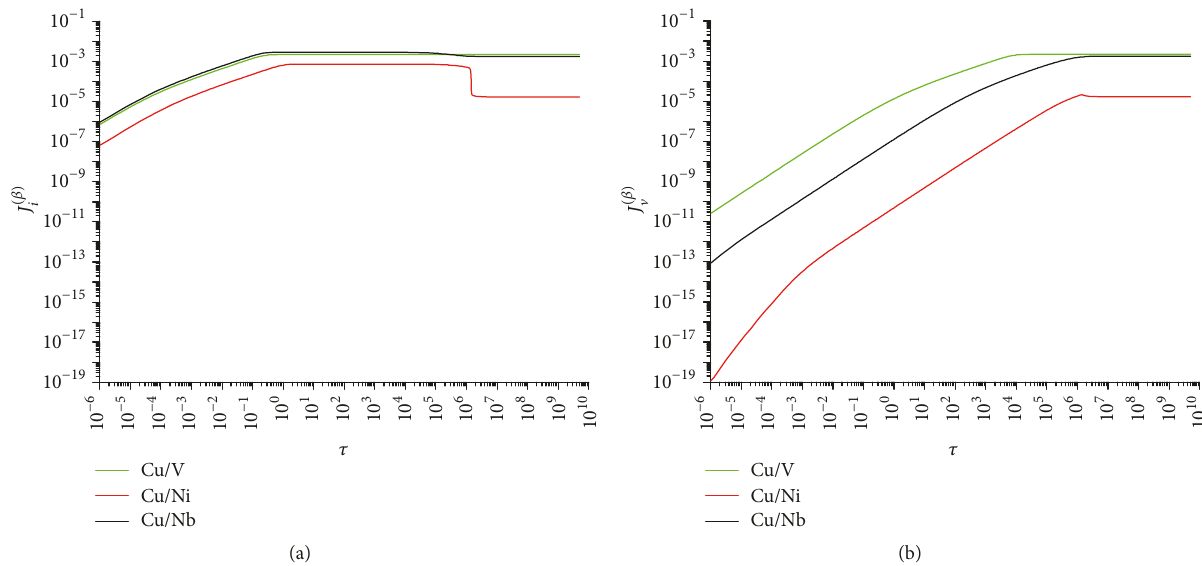
Figure 6: Temporal profiles of (a) SIA and (b) vacancy flux from layer 𝛽 to the interface between metals 𝛼 and 𝛽